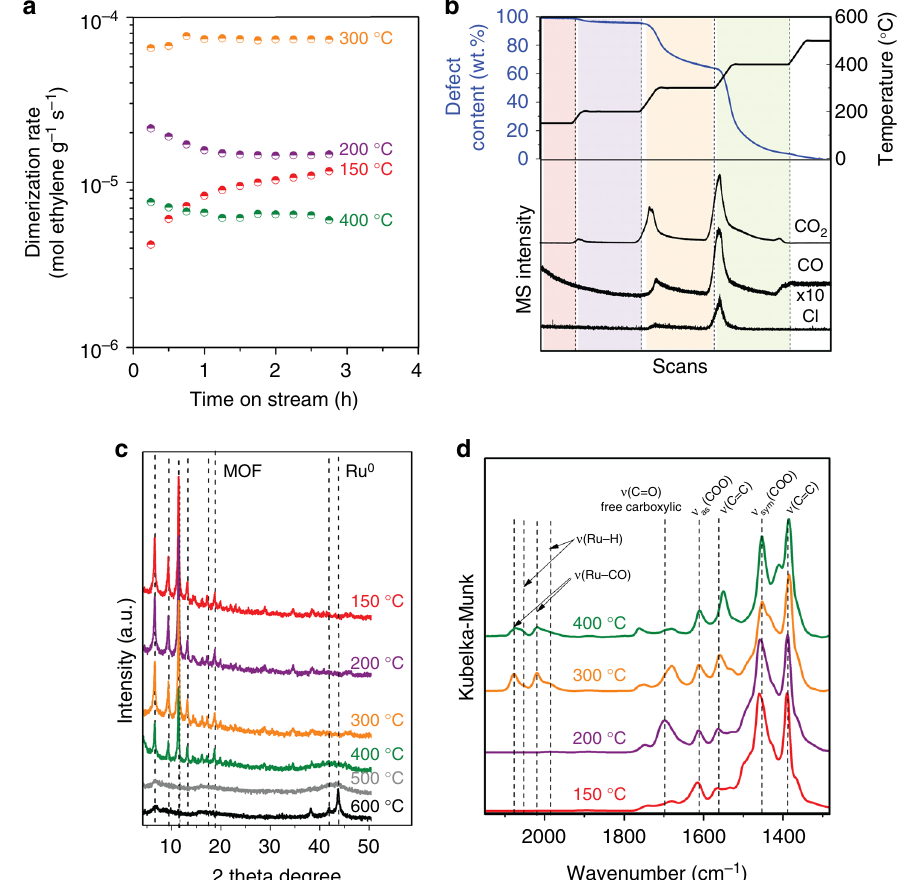
Fig. 3 Thermal treatment effects on activity, surface species, and structure of MOF L0 . a Ethylene dimerization rates at 50 °C and 4.2 MPa ethylene after MOF L0 thermal pre-treatment. b Thermogravimetric analysis (TGA) coupled to mass-spectrometry (MS) for MOF L0 . c XRD data for MOF L0 in N 2 . d DRIFT spectra of MOF L0 in N